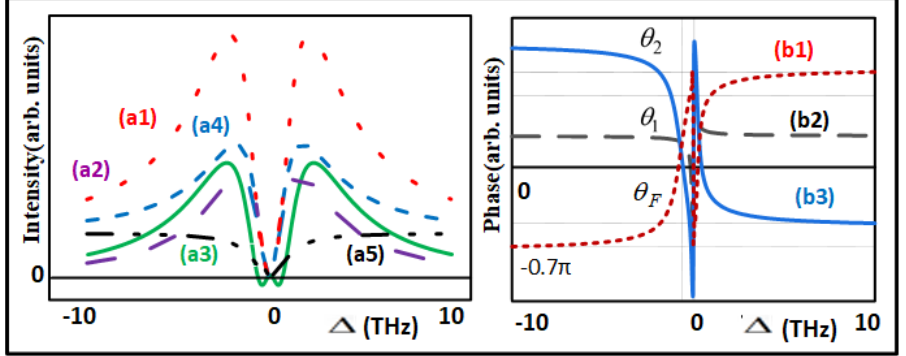
( 2 ) Figure 2. ( a1 ) The total signal intensity of | 2 + | ρ ( 2 ) | 2 (hot curve), ( a2 ) the interaction item Figure 2. ( a1 ) The total signal intensity of | ρ F 2 F 1 ( 2 ) || ρ ( 2 ) | cos ( θ ) versus ∆ (purple curve), ( a3 ) | ρ ( 2 ) | 2 (green curve), ( a4 ) | ρ ( 2 ) | 2 (blue curve), 2 | ρ sum F 2 F 1 F 1 ( 2 ) | 2 (black curve). Figure 2b: The parameters are G = 2.3 THz, G = 6.1 THz. ( b1 ) θ (black curve). Figure 2b: The parameters are 1 2.3 G = ( a5 ) | ρ F 2 1 F 2 (hot curve), ( b2 ) θ 1 (black curve), ( b3 ) θ 2 (blue curve) versus ∆ . Evolution of θ F , the constructive and the destructive interaction versus ∆ . Figure 2b: The destructive or constructive interaction is studied in this system interaction is studied in this system [23]. Table 1. Experimental parameters, Variables in the equations and Corresponding definition.